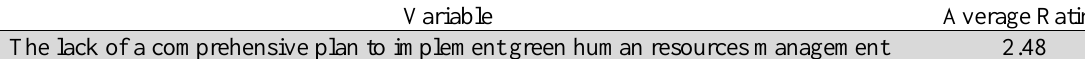
Results of Friedman test for the managerial factors